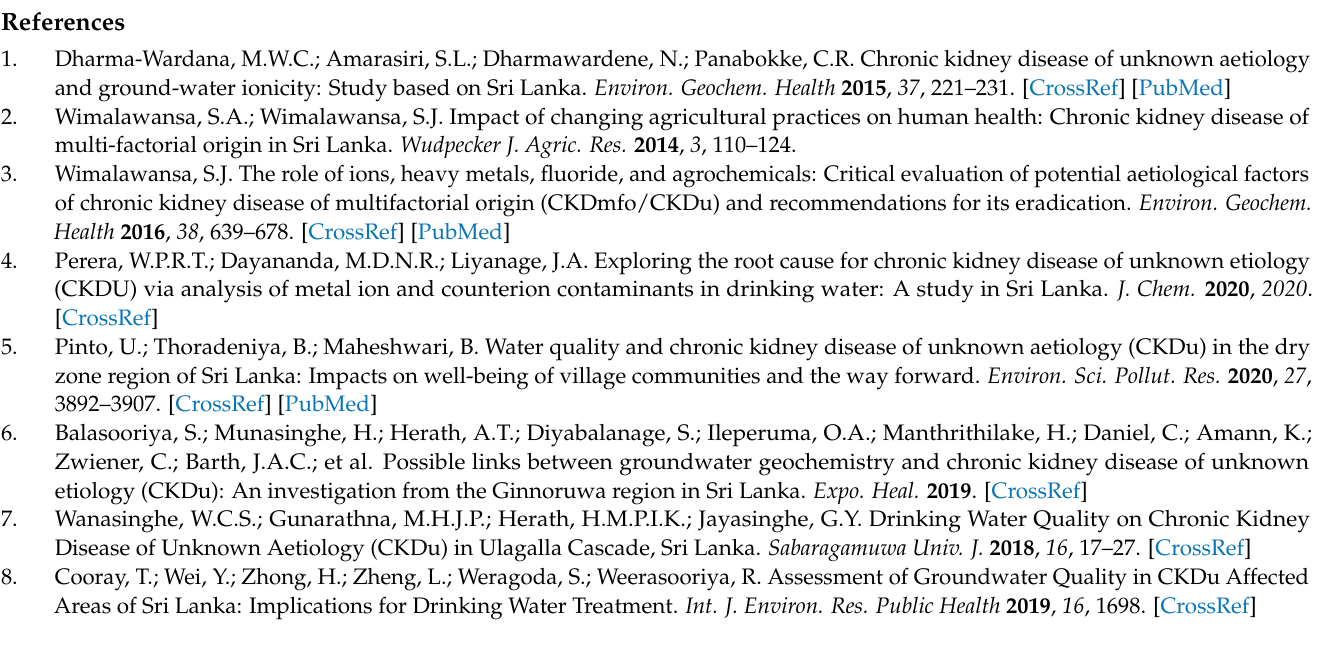
Figure S2. Different RO configurations that are common in NCP, Sri Lanka. Figure S3. Different op- tions for reject water handling. Figure S4. Number of RO systems with their system age (Y). Figure S5. Percentage of the number of CBO-operated RO facilities ( x -axis) in the NCP with their membrane replacement intervals ( x -axis). Figure S6. Number of RO plants ( y -axis) with the categorization by their water recovery as a percentage ( x -axis). Figure S7. Tested (by manufacturer) operating pressure vs. actual operating pressure of selected RO systems in the NCP. Figure S8. Hardness rejection of each RO station. Figure S9. Alkalinity rejection rates of each RO station. Figure S10. Overall salt rejection for each RO plant (95 ROs) operated under CBOs ( x -axis: RO plant number, y -axis: % salt rejection). Figure S11. Total income and total operating cost of each RO station in the NCP. Table S1. RO product water prices with their operating companies. Table S2. Diversity of RO system configurations in CBOs in the NCP. Table S3. Specification data of each RO membrane type used in RO stations in the NCP. Table S4. Influence of feedwater chemistry for ion rejection of ESPA2 membranes. Table S5. Selected RO membranes for comparison of individual ion rejection. Table S6. Estimation of production cost for drinking water in a typical RO station in